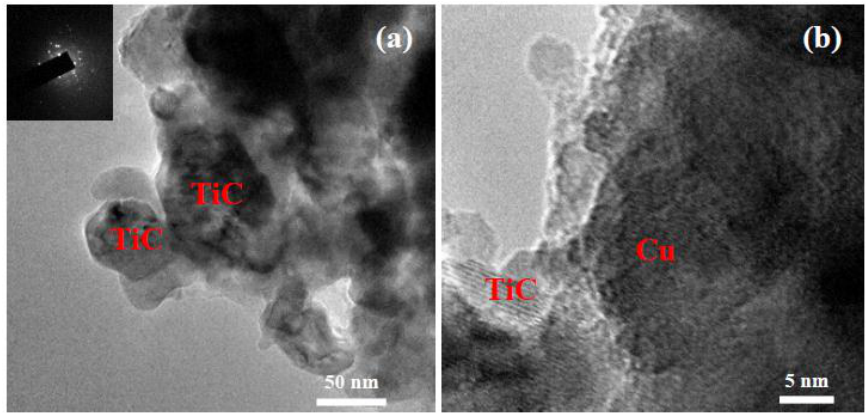
Figure 9. TEM images and SADP of nanocomposite B of 30 vol % TiC–Cu composition sintered at 900°C: ( a ) bright-field image (inset: SADP corresponding to a TiC crystallite); ( b ) HRTEM of the Cu matrix.